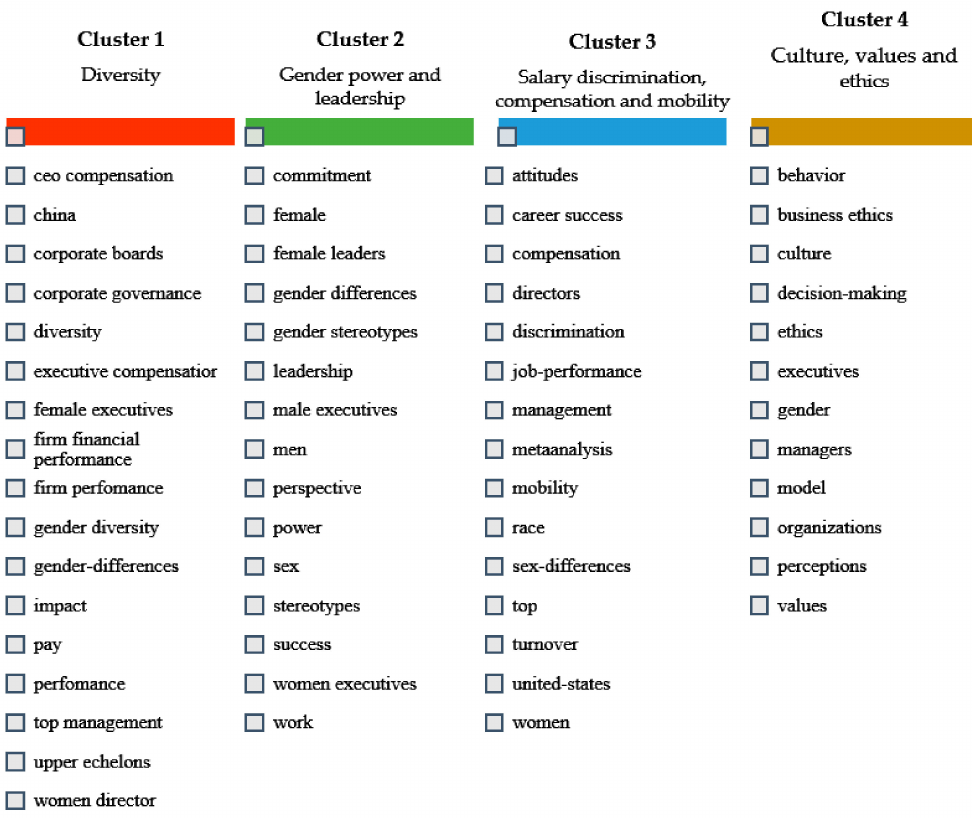
Figure 4. Keywords grouped by clusters. Source: Prepared by the